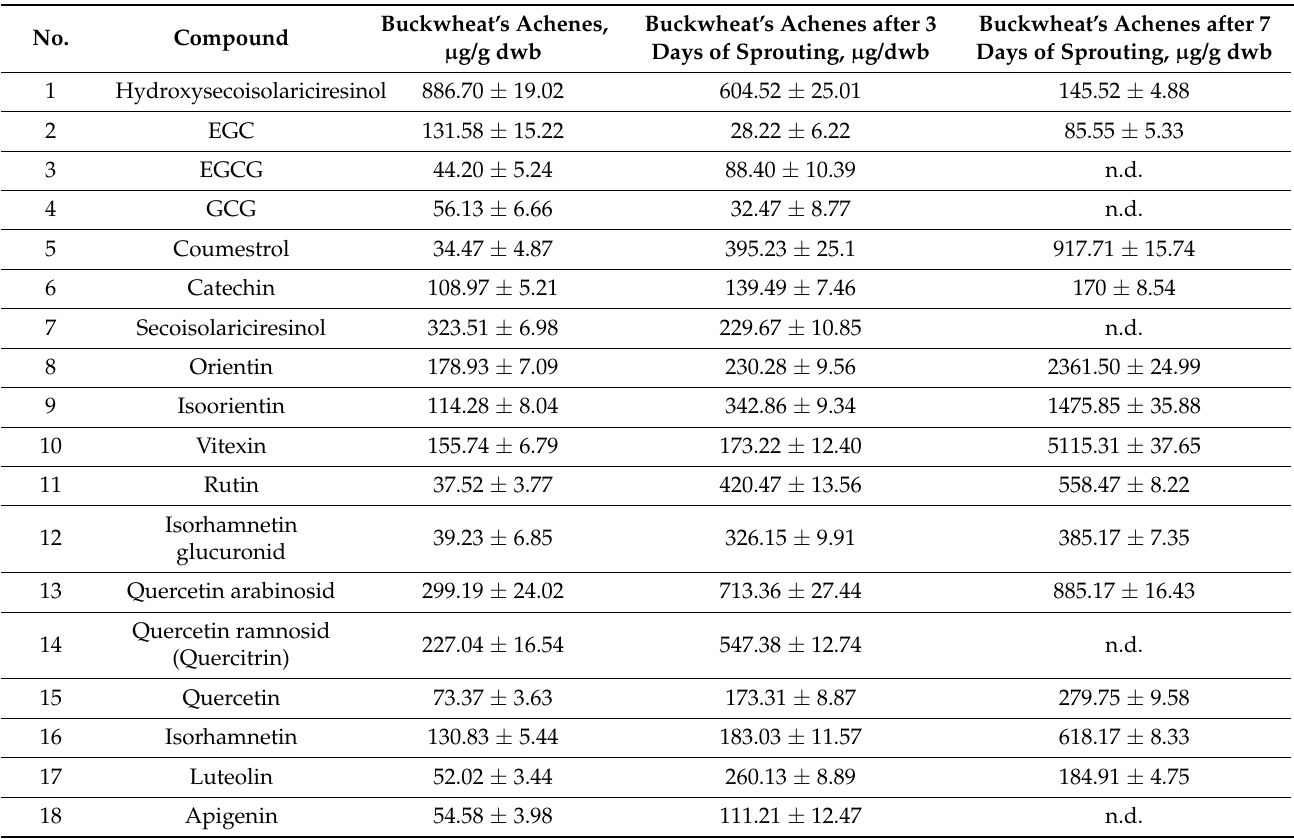
Table 4. The concentrations of flavonoids extracted, in µ g/g dw, in buckwheat achenes, and buckwheat achenes after 3 and 7 days of